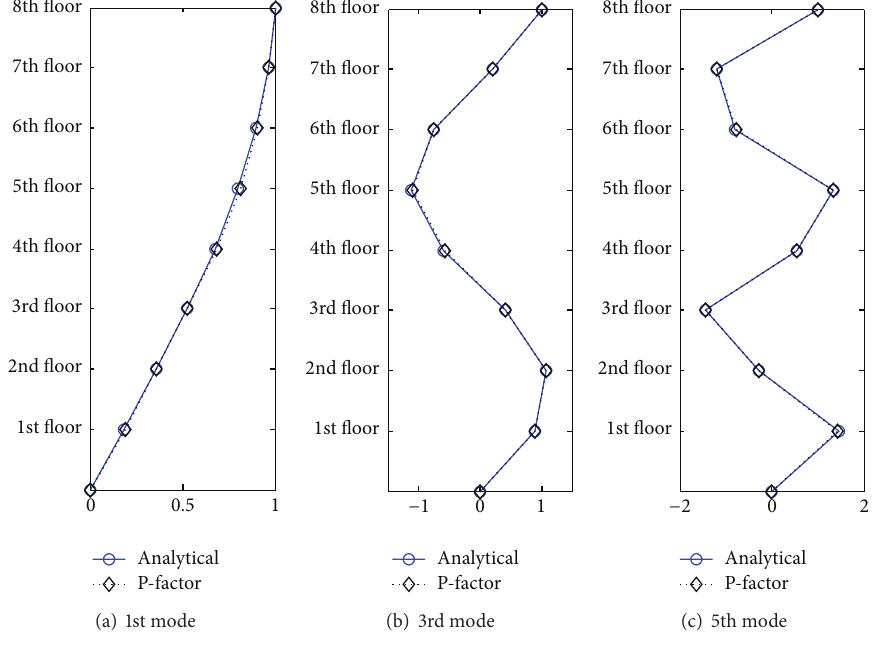
Figure 6: Mode shape